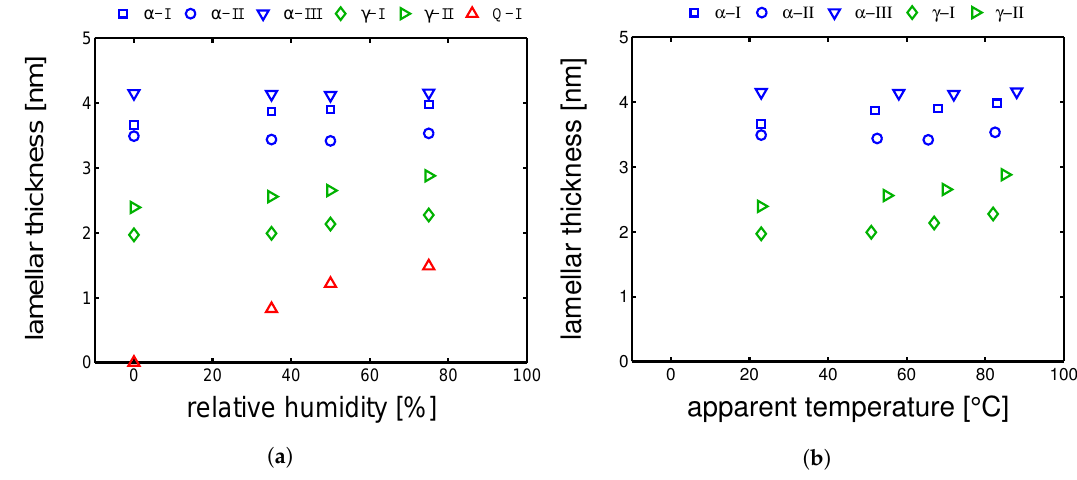
Figure 15. Lamellar thicknesses as functions of ( a ) relative humidity and ( b ) apparent temperature. All conditioning were performed at 23